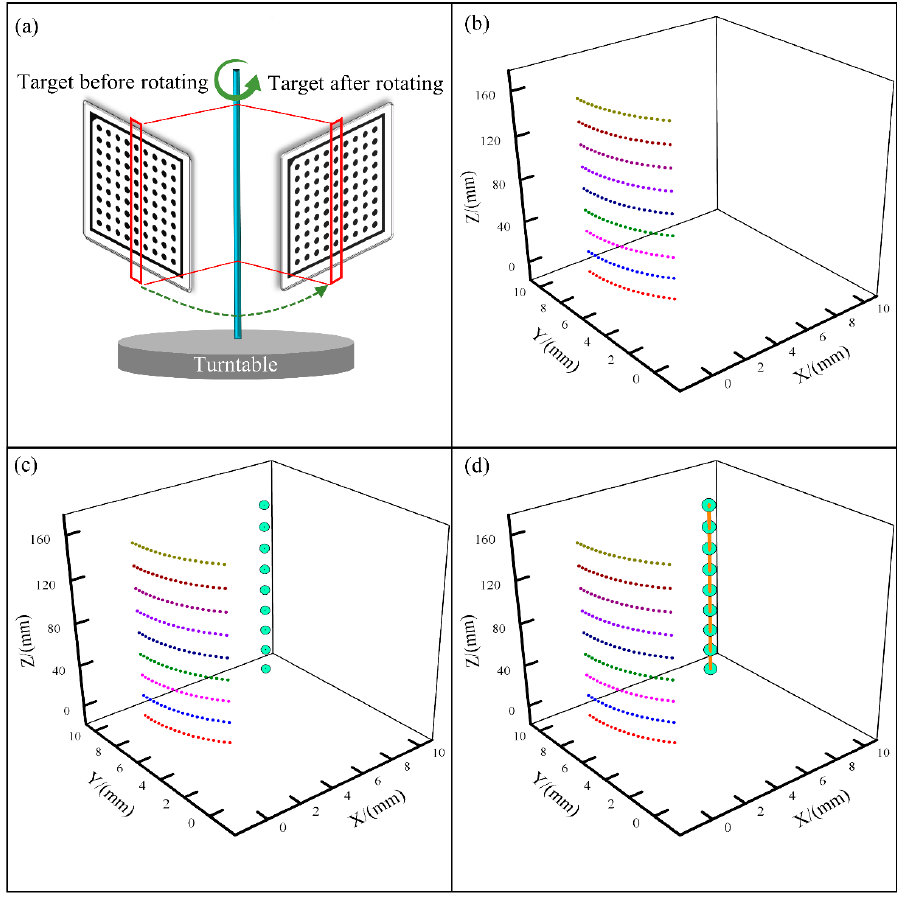
Figure 5. Calibration of turntable axis: ( a ) process of calibrating the turntable axis; ( b ) obtained point sets in different colors; ( c ) circle center fitting; ( d ) turntable axis fitting.